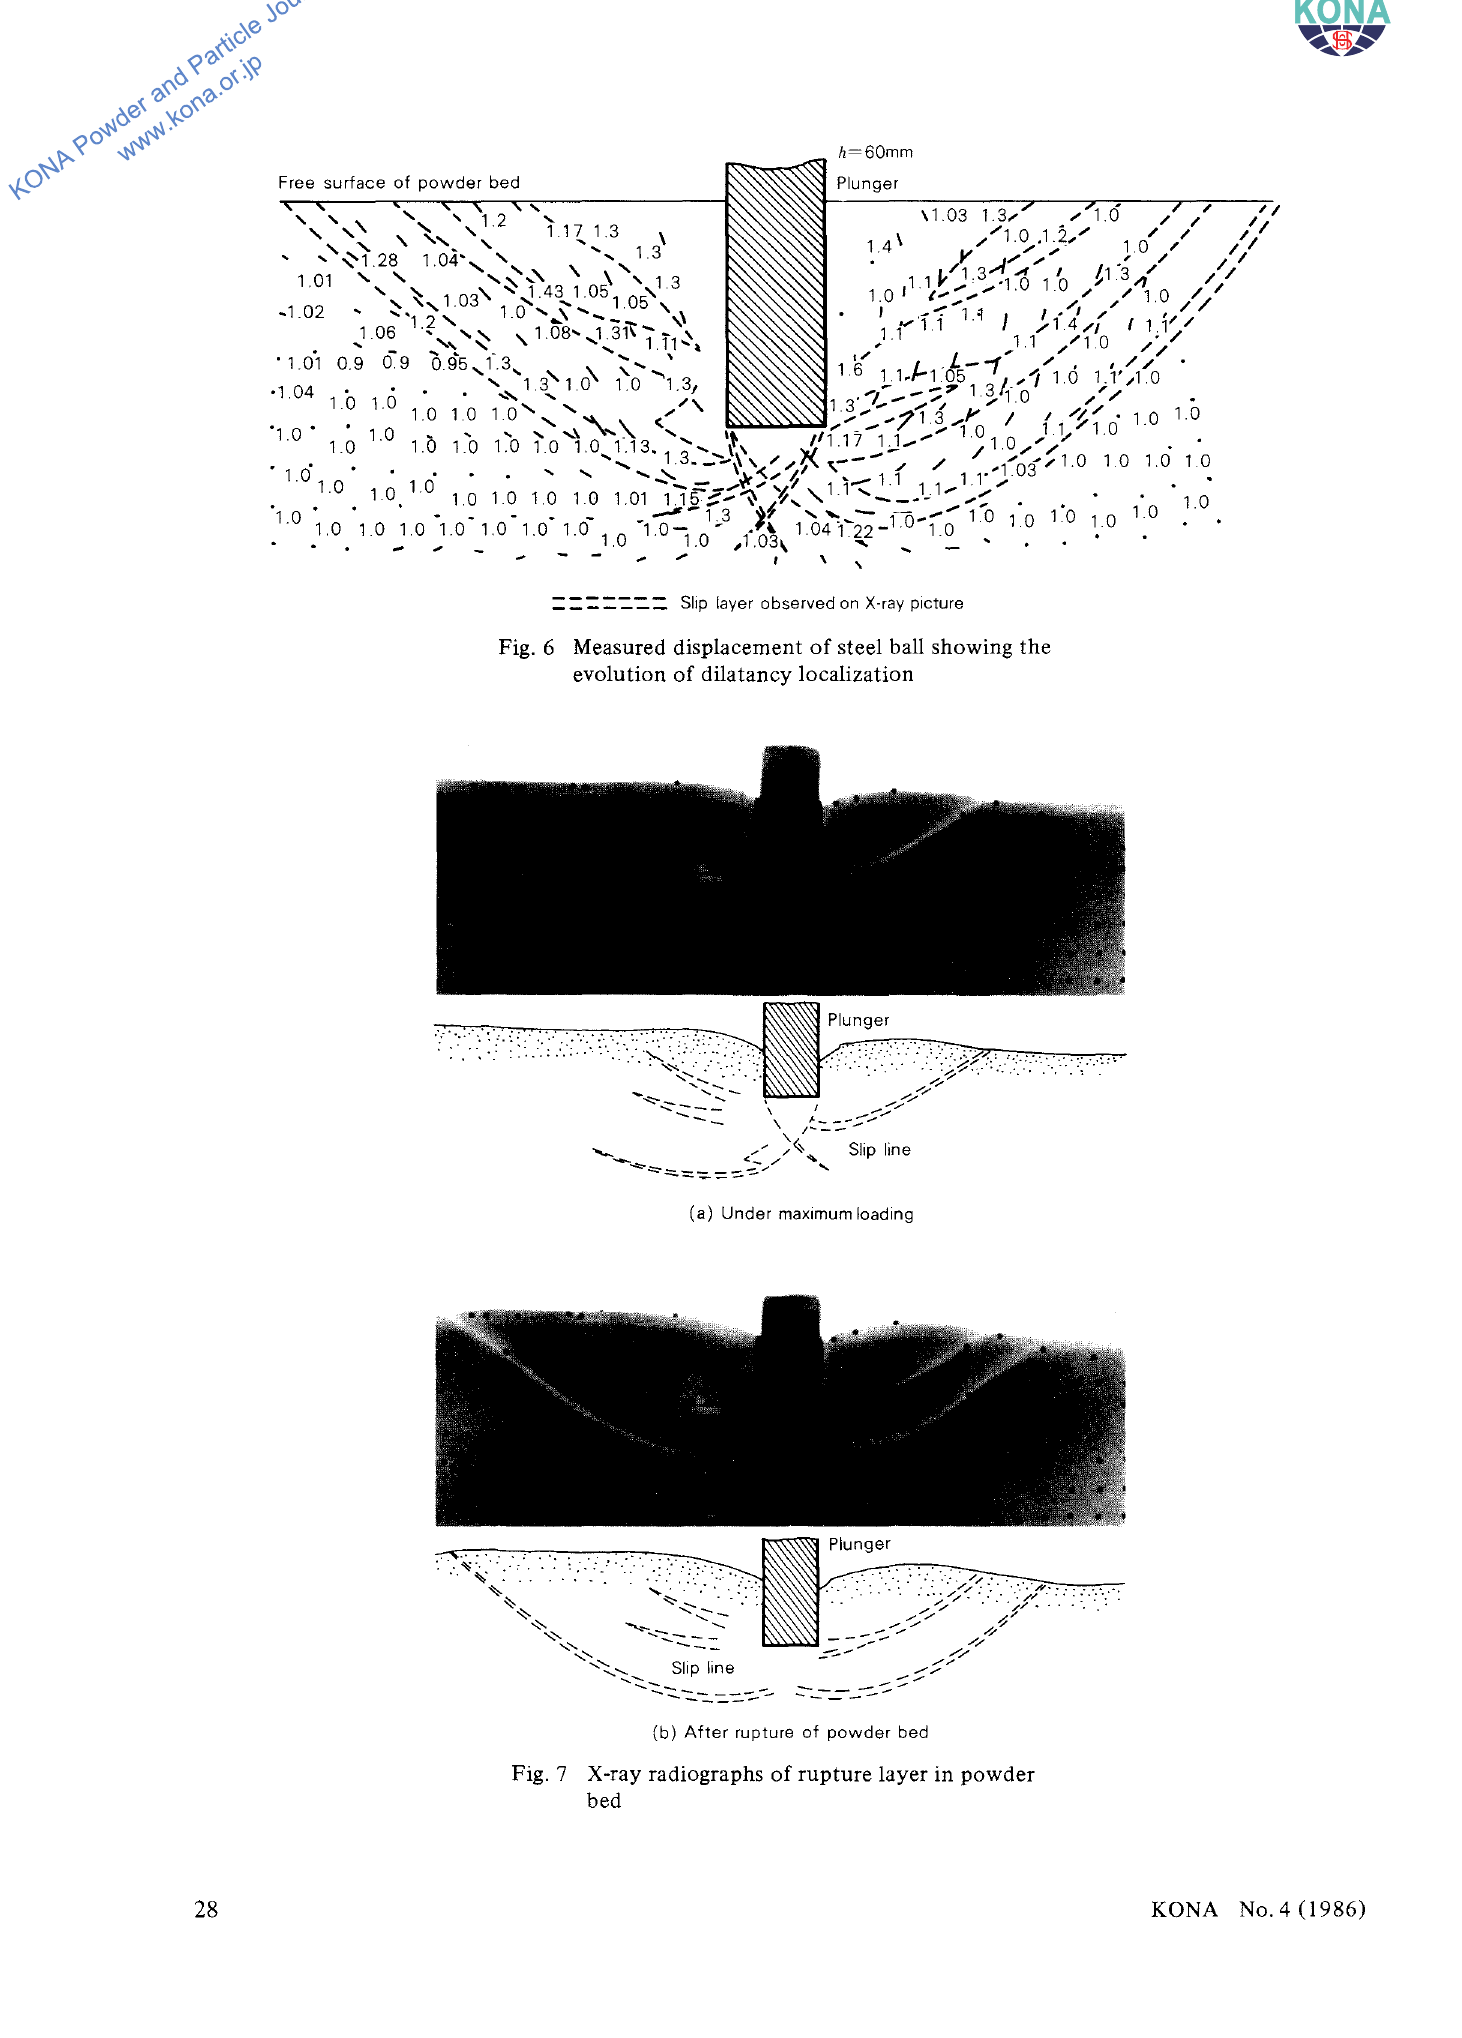
Fig. 6 Measured displacement of steel ball showing the